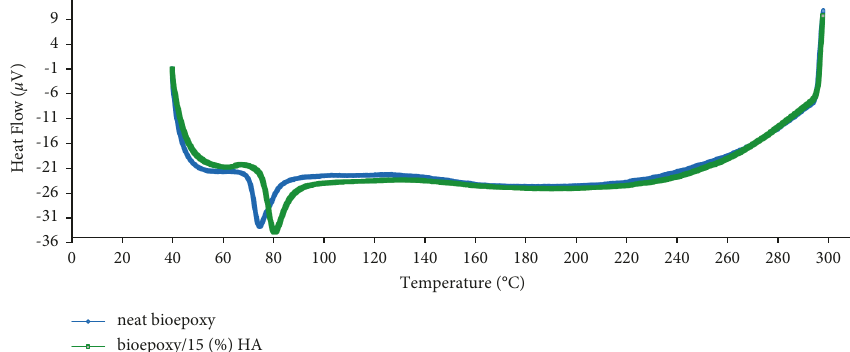
Figure 8: DSC curves for pristine bioepoxy and bioepoxy/15wt% HA nanocomposite.